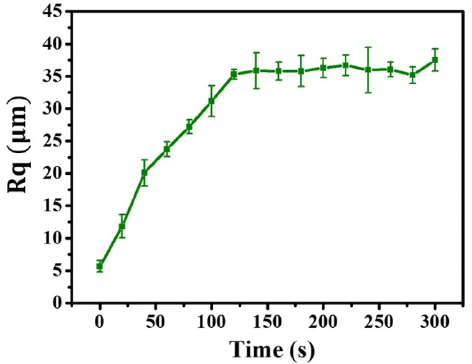
Figure 4. Variation of the surface roughness with demineralization time. This figure was adapted from [81] and was created with Microsoft Word (Microsoft Corp., Redmond, WA, USA). 4.8. Quantitative Assessment Based on the Volume of Residual Enamel Demineralization caused by caries lesions changes the volume of residual enamel.